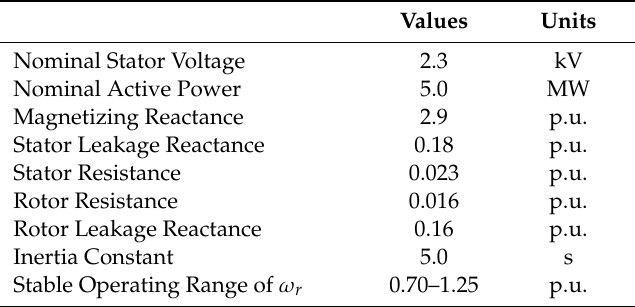
Table 3. Parameters of the DFIG.